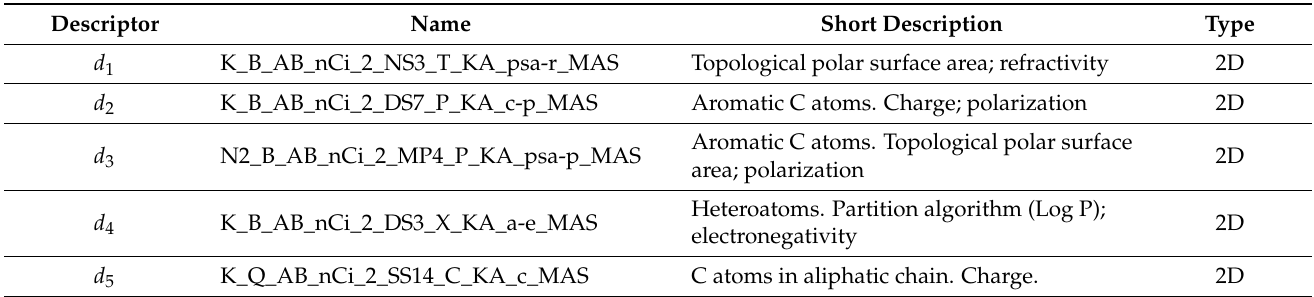
Table 4. Molecular descriptors in the QSAR model of toxicity as described by Equation